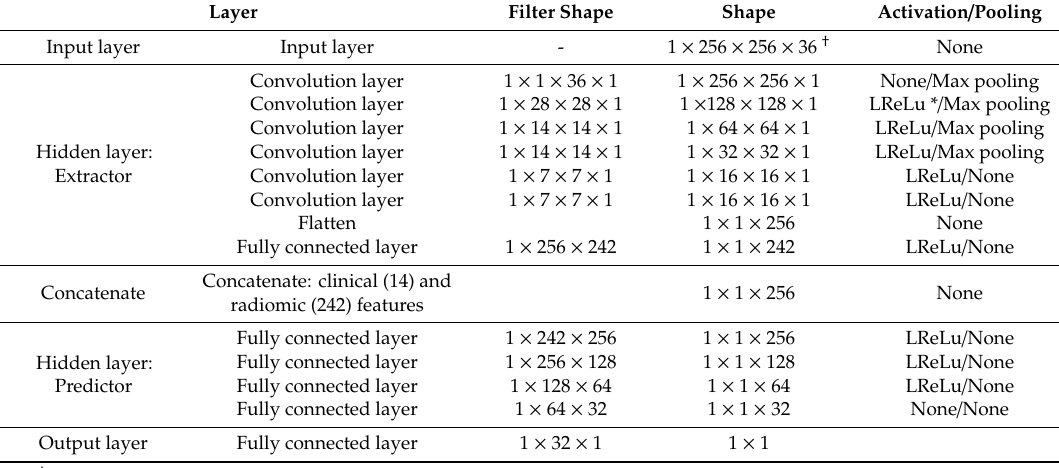
Table 5. Layers and parameters of the prediction model employing both the clinical and radiomic features (M CR ).